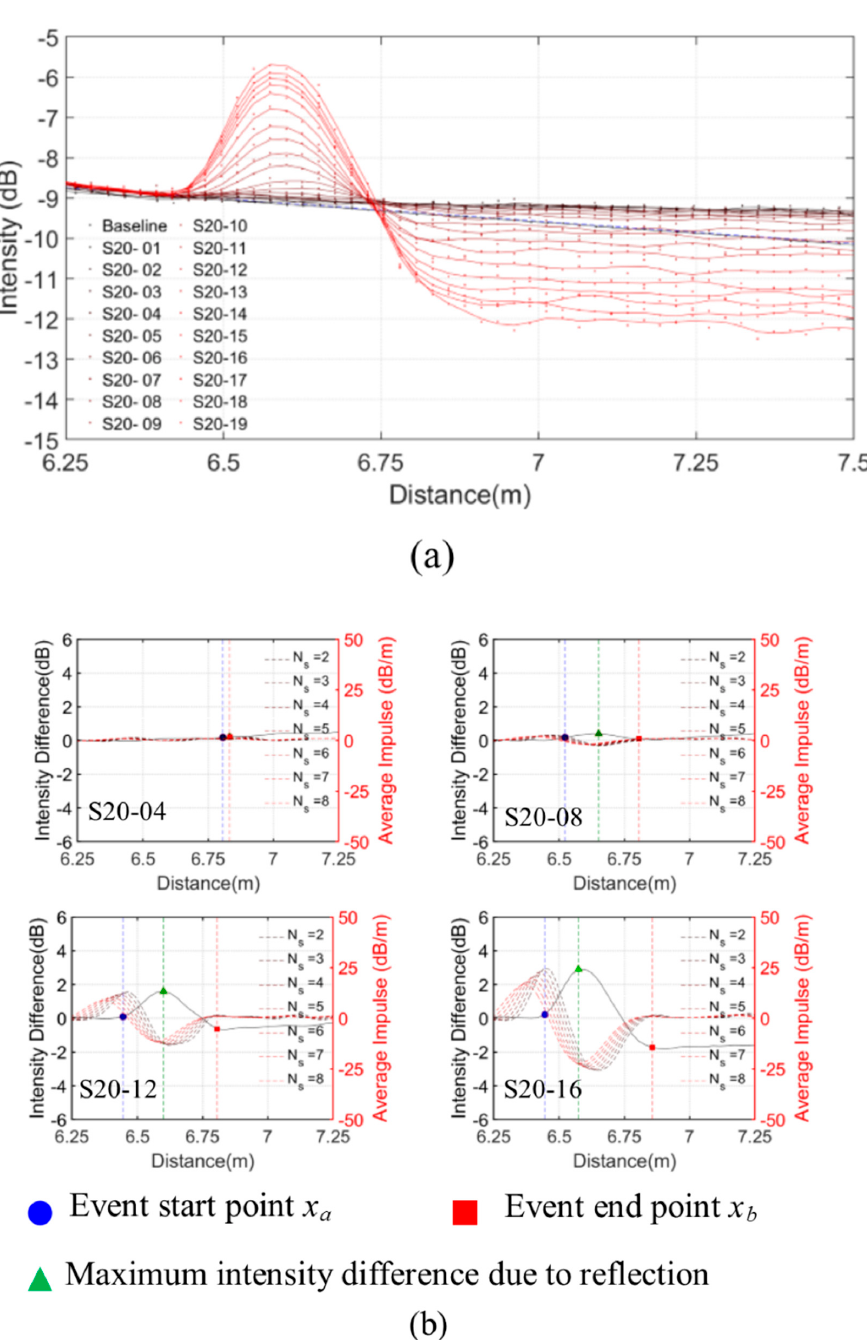
Figure 6. Single shear event with a deformed length of 20 mm: ( a ) ν -OTDR traces; ( b ) locating the event start points, the endpoints, and the maximum reflection intensity using the intensity di ff erence (left axis) methods with the impulse for di ff erent N s (right axis).